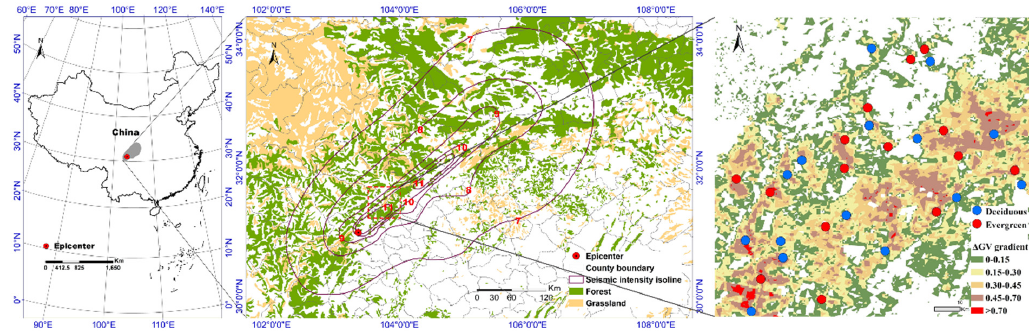
Figure 1. The location of Wenchuan earthquake and field sample plots.